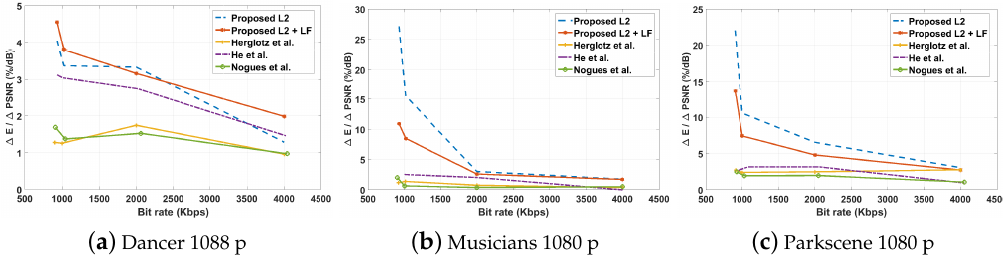
Figure 6. An illustration of the variation of the ∆ E , ∆ PSNR ratio, i.e., (cid:99) ∆ E ( %/dB ) , with respect to the bit rate for ( a ) Dancer, ( b ) Musicians and ( c ) Parkscene HD test